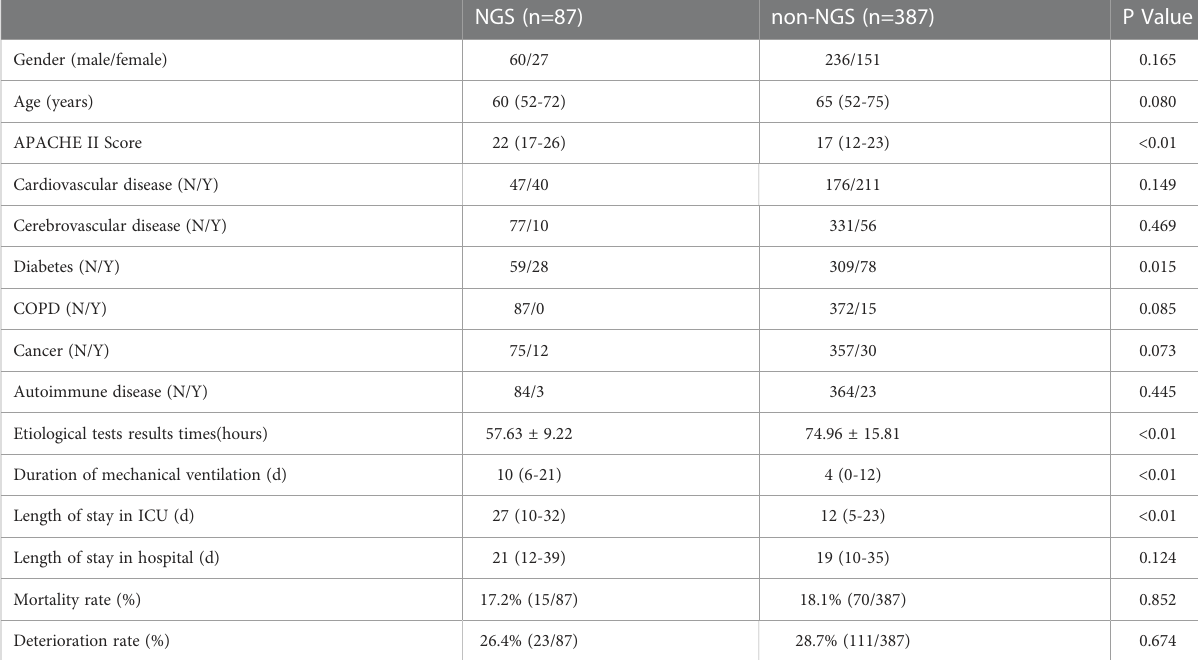
TABLE 3 Baseline characteristics and clinical indices of NGS and non-NGS groups of 87